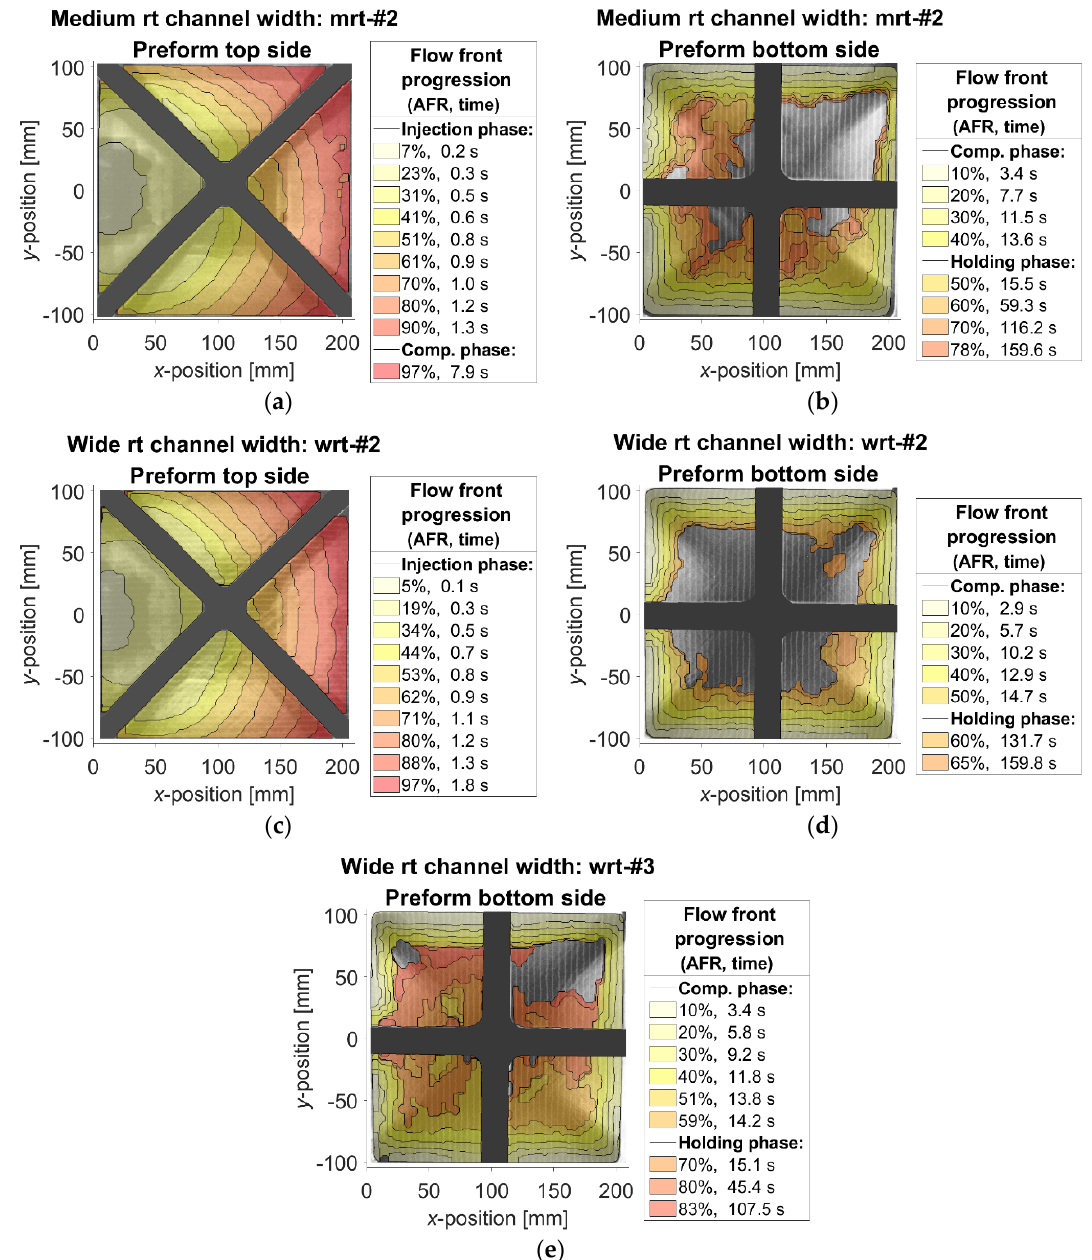
Figure A6. Flow front progression of FS-CRTM experiments of the race-tracking study: ( a , b ) medium race-tracking (rt) channel width—mrt-#2; ( c , d ) wide race-tracking channel width—wrt-#2; ( e ) wide race-tracking channel width—wrt-#3—no pictures of the preform top side were recorded during the injection of wrt-#3 due to issues of the data acquisition equipment (AFR = area filling ratio).